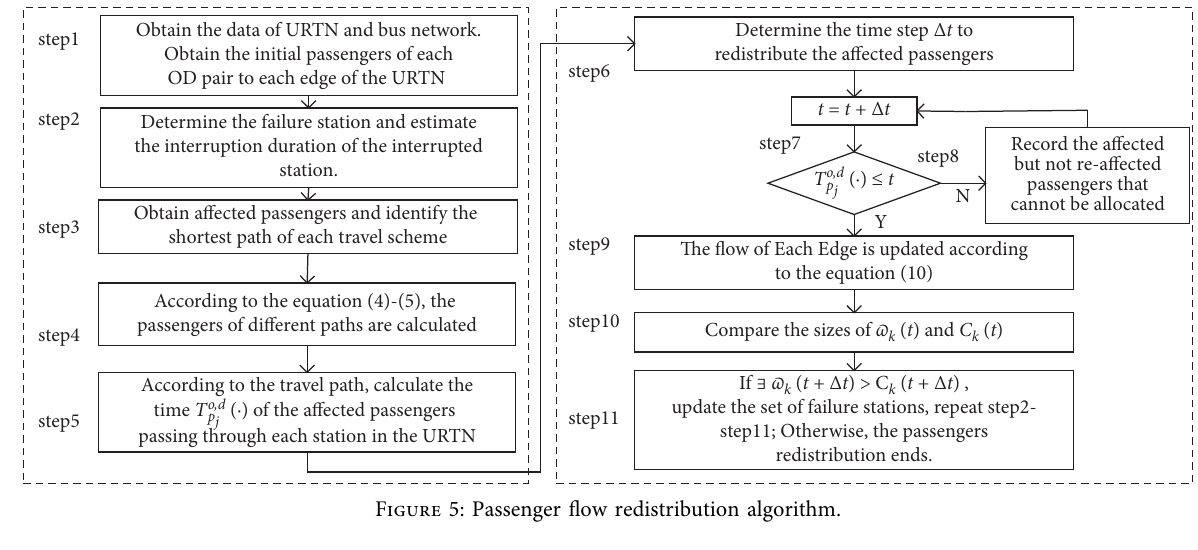
Figure 5: Passenger flow redistribution